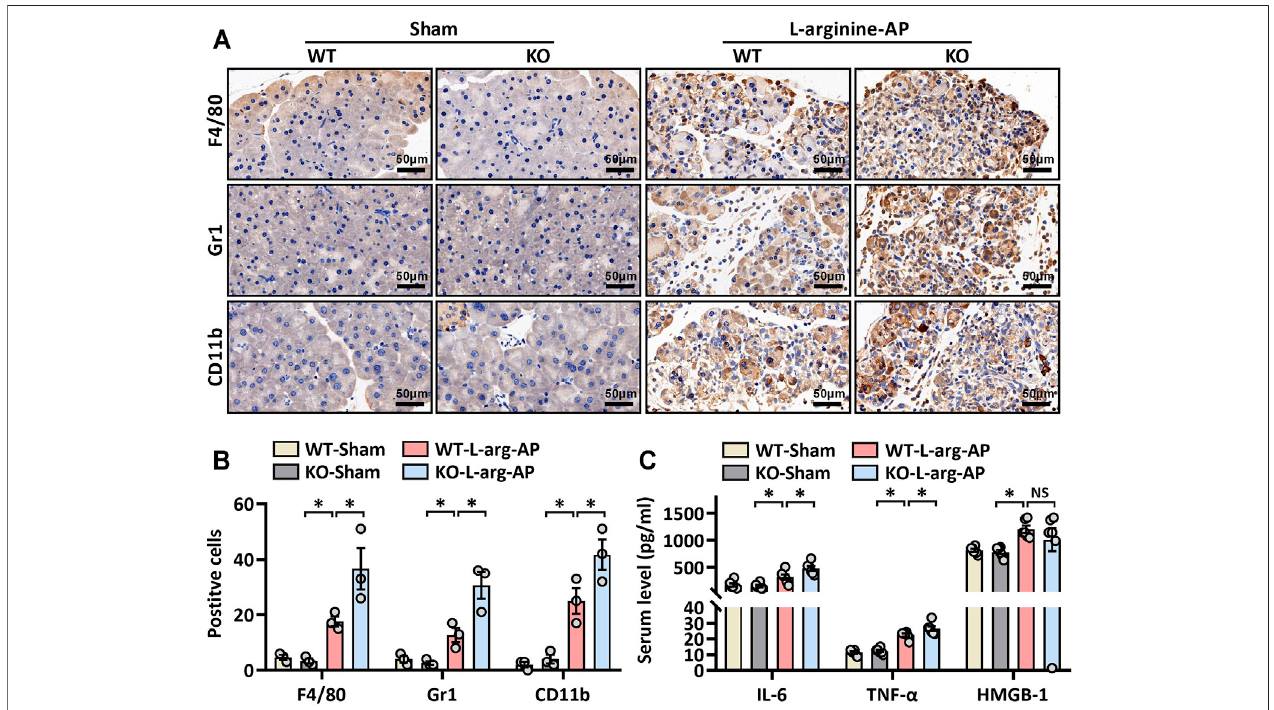
FIGURE 5 | MFG-E8 de fi ciency aggravated pancreatic in fl ammatory response in L-arginine-treated mice. In mice, arginine-AP stress was induced by 2 hourly intraperitoneal injections of 4.0 g/kg L-arginine. At 2 h after the last injection of L-arginine, normal saline (vehicle) or 20 μ g/kg MFG-E8 were administered through intraperitoneal injection. The animals were sacri fi ced at 69 h after MFG-E8 treatment (i.e., 72 h after the fi rst injection of L-arginine). Blood and tissue samples were collected. (A) Representative photos of F4/80, CD11b, and Gr1 staining; (B) Quantitative ofF4/80, CD11b, and Gr1 staining; (C) Serum TNF- α , IL-6 and HMGB-1 levels. n (cid:1) 4 – 6/group,errorbarsindicatetheSEM; p p < 0.05versusShamgroup;# p < 0.05versusVehiclegroup.WT,wildtype;KO,knockout;MFG-E8,milkfatglobule EGF factor 8; AP, acute pancreatitis; HMGB-1, High mobility group box